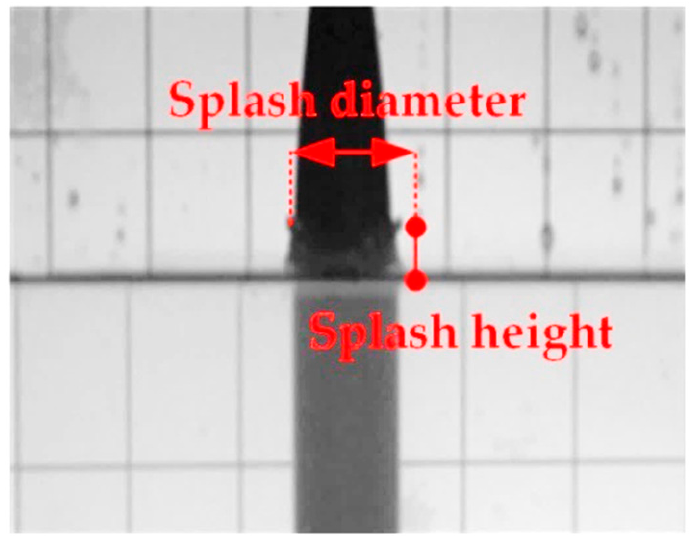
Figure 13. The splash diagram of the hydrophilic model with the initial velocity of water entry v = 3.95 m/s and the head shape hemispherical angle of 0°.